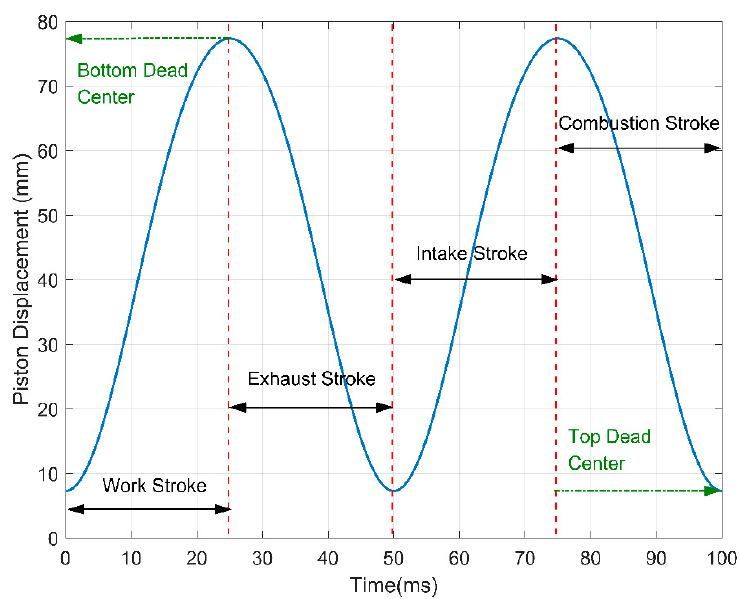
Figure 6. Four-stroke operation mode of the engine.